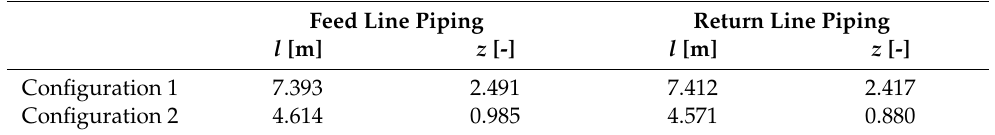
Table 3. Summary of parameter values that differ between the two configurations of application example one. The cooling distribution system routing is subject to modification. The remaining coolant distribution system components, along with their constituent parameters, remain unchanged. Feed Line Piping Return Line Piping l [m] z [-] l [m] z [-] Configuration 1